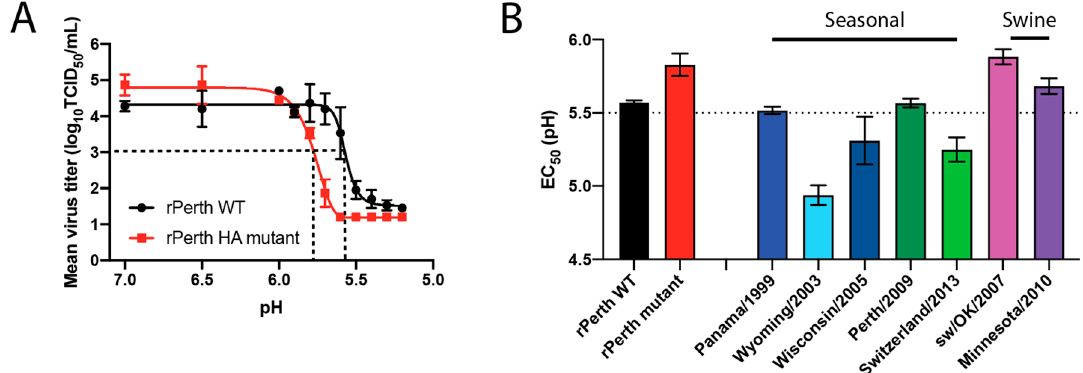
Figure 3. rPerth mutant had decreased HA stability. ( A ) rPerth WT (black line) and mutant (red line) were treated in pH-adjusted PBS for 1 h at 37 °C. Remaining virus titers were determined by TCID 50 assay. The experiment was performed in triplicate, and representative data are shown. The data were fit with an asymmetric sigmoidal curve to determine the EC 50 . The limit of detection was 1.2 log 10 TCID 50 /mL. ( B ) Seasonal and swine H3N2 viruses were incubated in PBS of different pHs for 1 h at 37 °C, with experiments performed in triplicate. The remaining virus titers were determined by TCID 50 assay and the EC 50 values were plotted using regression analysis of the dose–response curve. The reported mean (±SD) corresponds to two independent biological replicates, each performed in triplicate.